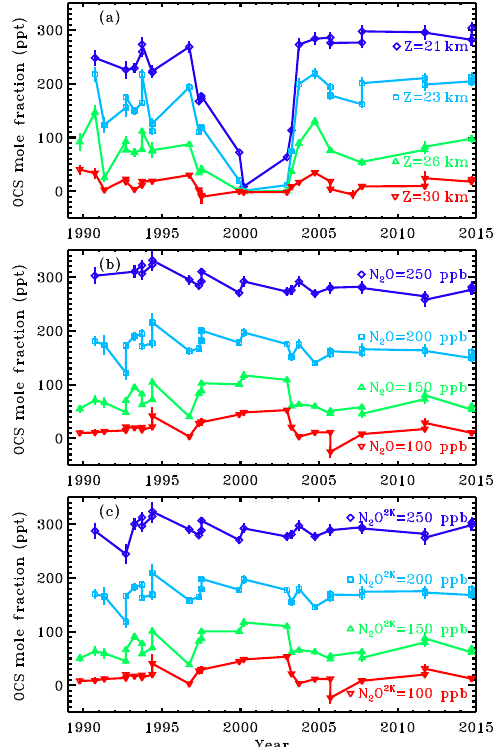
Figure 3. (a) Stratospheric OCS dry mole fractions interpolated onto four different altitudes (21, 23, 26, and 30km) using the data from Fig. 1. (b) The same OCS data interpolated to various N 2 O isopleths. The 250ppb isopleth (red) corresponds to ∼ 21km al- titude at mid-latitudes, whereas the 100ppb isopleth (blue) corre- sponds to ∼ 30km. (c) Same as (b) , but with the N 2 O amounts de- trended by 0.25%yr − 1 , as in Fig.